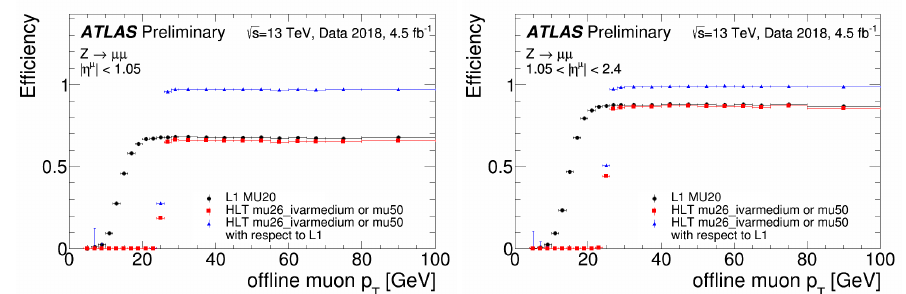
Figure 3. Illustration of the impact parameters of a track in the transverse plan (left) and RZ- Figure 4. Absolute e ffi ciency of L1_MU20 (black dots), absolute e ffi ciency of the OR of plane (right). The transverse impact parameter d 0 is defined as the distance of closest approach to mu26_ivarmedium and mu50 (red squares), and the e ffi ciency of the OR of mu26_ivarmedium and the beam line (z-axis). The longitudinal impact parameter z 0 is defined as the value of z of the point mu50 relative to L1_MU20 (blue triangles) as a function of p T of o ffl ine muon candidates. The plots on the track that determines d 0 . A more detailed description of the impact parameters can be found in are shown for barrel (left) and endcap (right) Ref. [4]. Table 1. The rate and e ffi ciency of the isolated muon trigger with a p T threshold of 26 GeV (mu26_ivarmedium) for three ∆ z requirements.